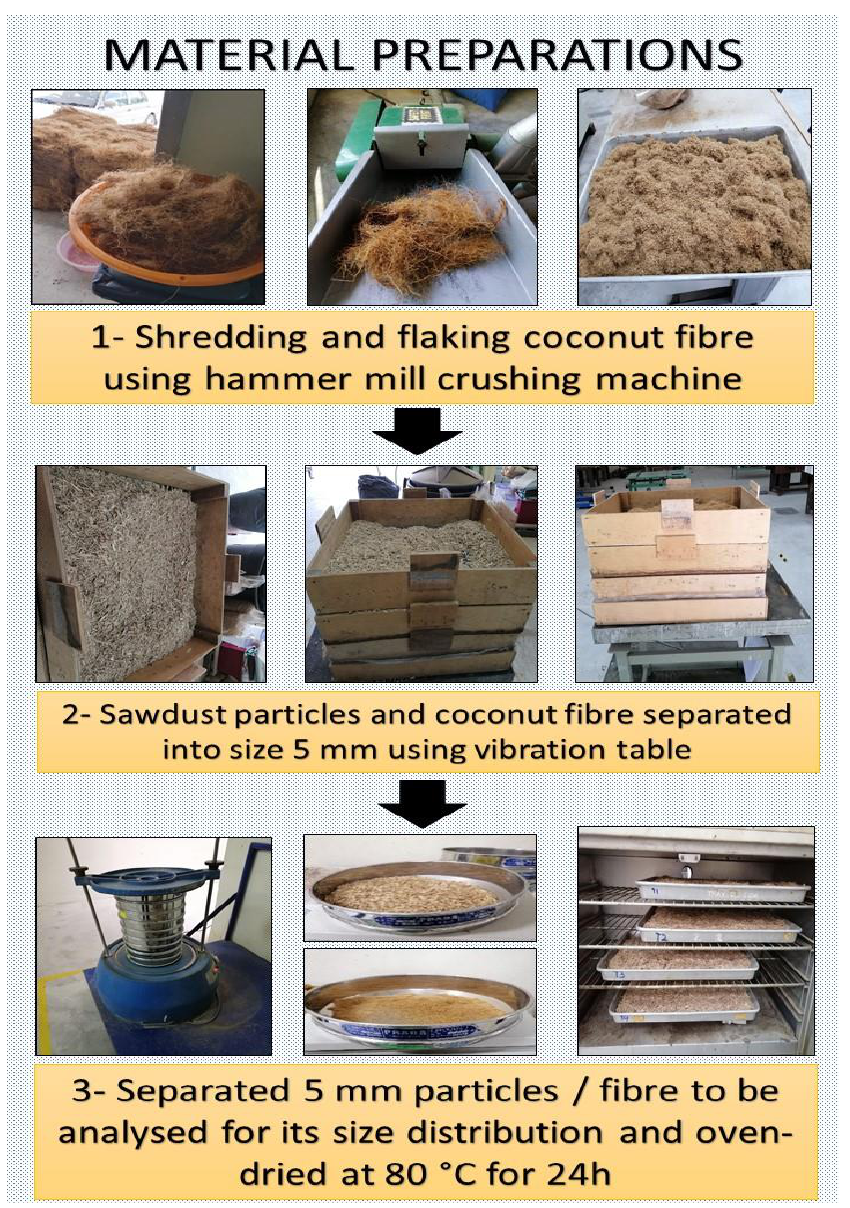
Figure 2. Sawdust Particle and Coconut Fibre Preparations.